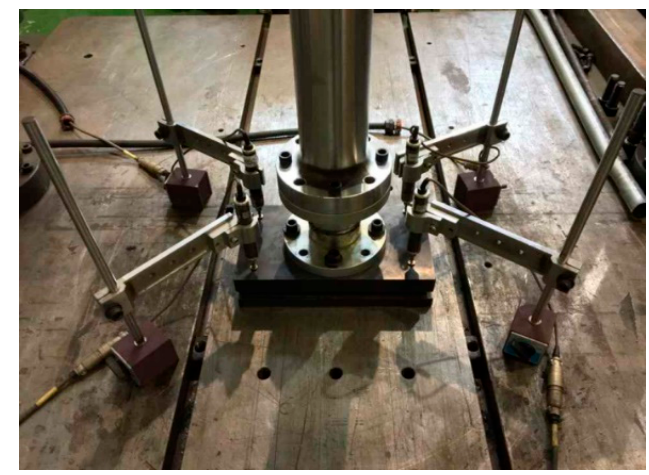
Figure 17. Photograph of the rail pad spring stiffness test apparatus.